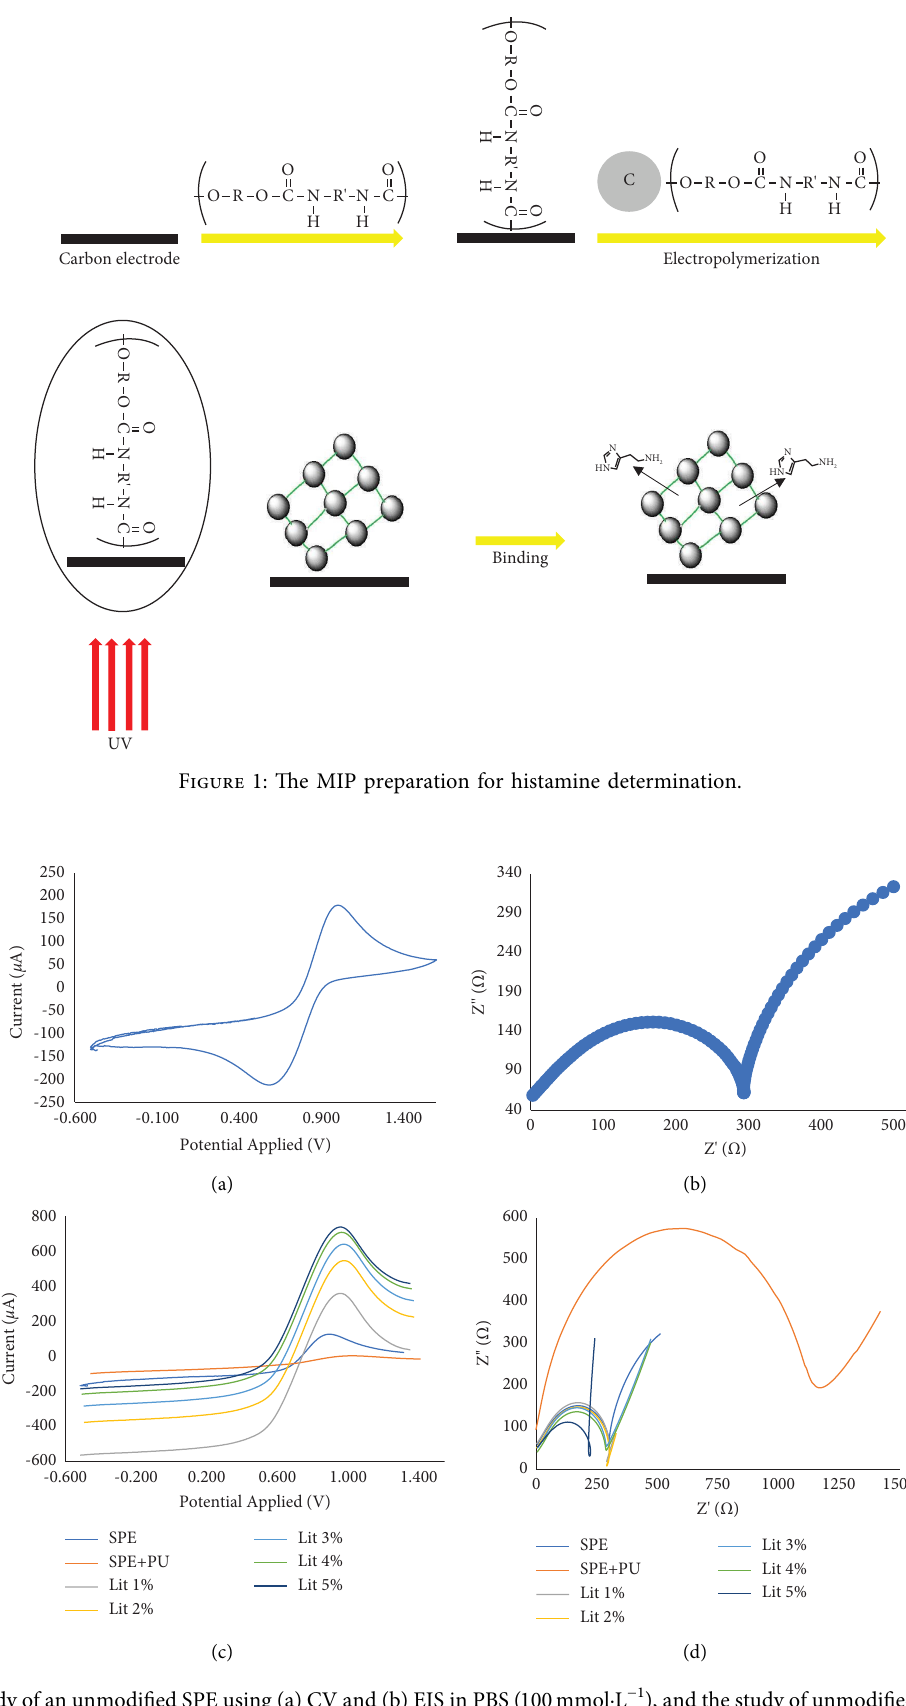
Figure 2: Te study of an unmodifed SPE using (a) CV and (b) EIS in PBS (100mmol · L − 1 ), and the study of unmodifed and modifed SPE using various concentrations of lithium perchlorate using (c) CV and (d) EIS in PBS (100mmol · L − 1